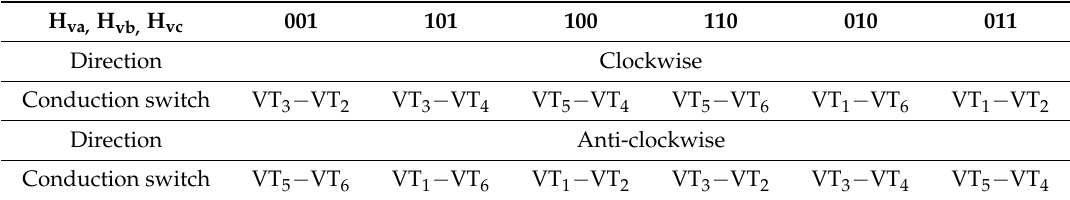
Table 3. Predefined commutation sequence.